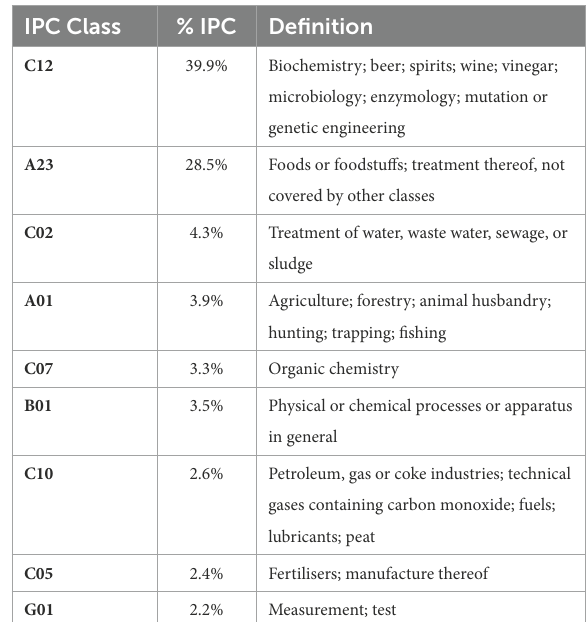
TABLE 2 Percentage of patents found considering the 10 main class IPCs registered and definition of the corresponding